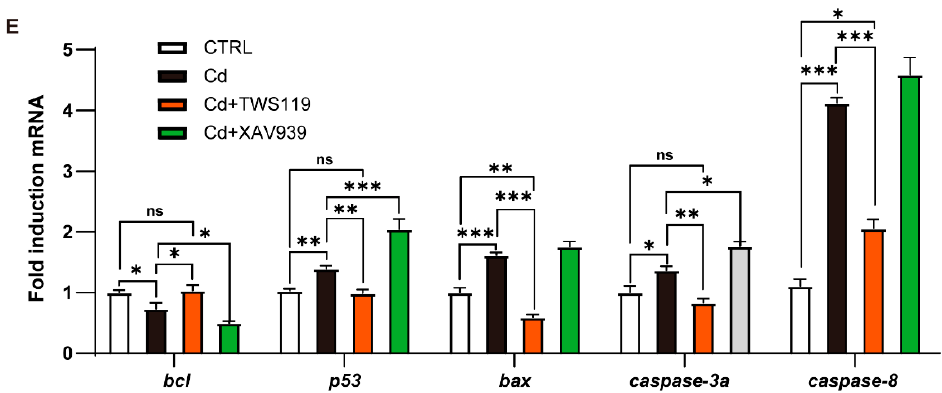
Figure 5. Apoptosis and cell cycle arrest in zebrafish larvae caused by Cd 2+ are mediated by Wnt signaling pathway. ( A , B ) Flow cytometry analysis and distribution of cell cycle phase of neurons and neuronal precursor cells. ( C , D ) Vertical view in the brain of AO-stained zebrafish larvae (6 dpf) and statistics of apoptotic cell numbers. ( E ) Relative expression analysis of genes related to cell apoptosis. In histograms, values are represented as mean ± SEM, while in boxplots, values are represented as median and mean, and whiskers signify 90% confidence interval. The results of nonparametric test and ANOVA, as well as multiple comparison test are listed in Table S2. “*” indicates significant differences (* p < 0.05, ** p < 0.01, *** p < 0.001).